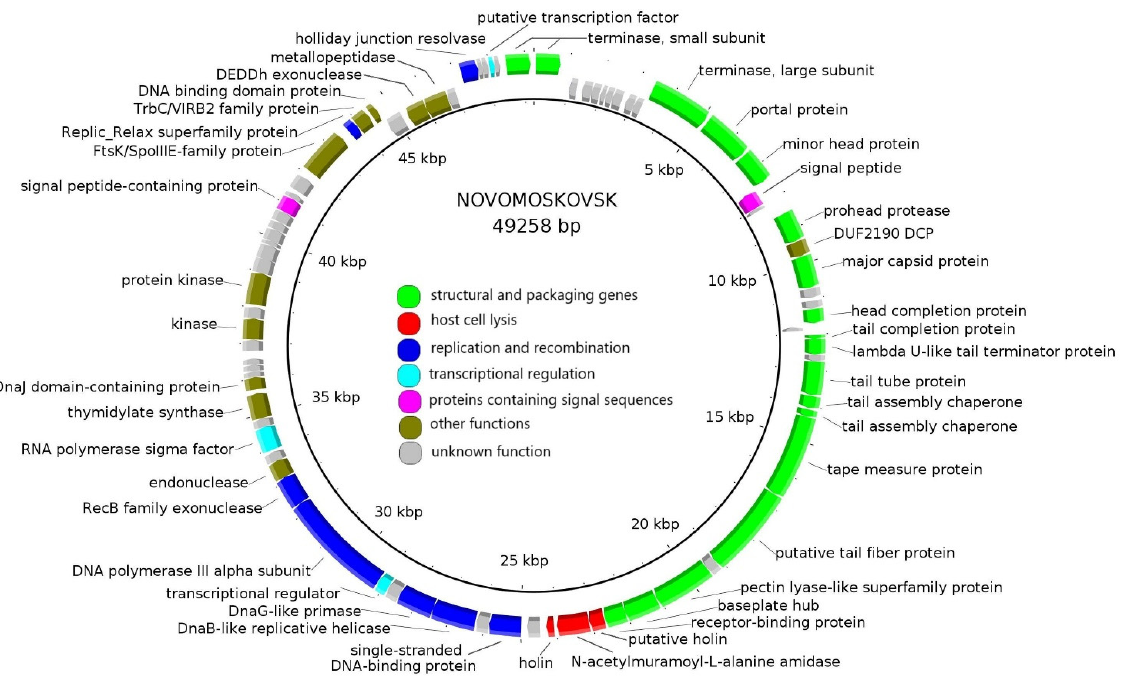
Figure 2. The Bolokhovo genome map. Functionally assigned ORFs are colored according to their general functions (see the color labeling scheme in the center).